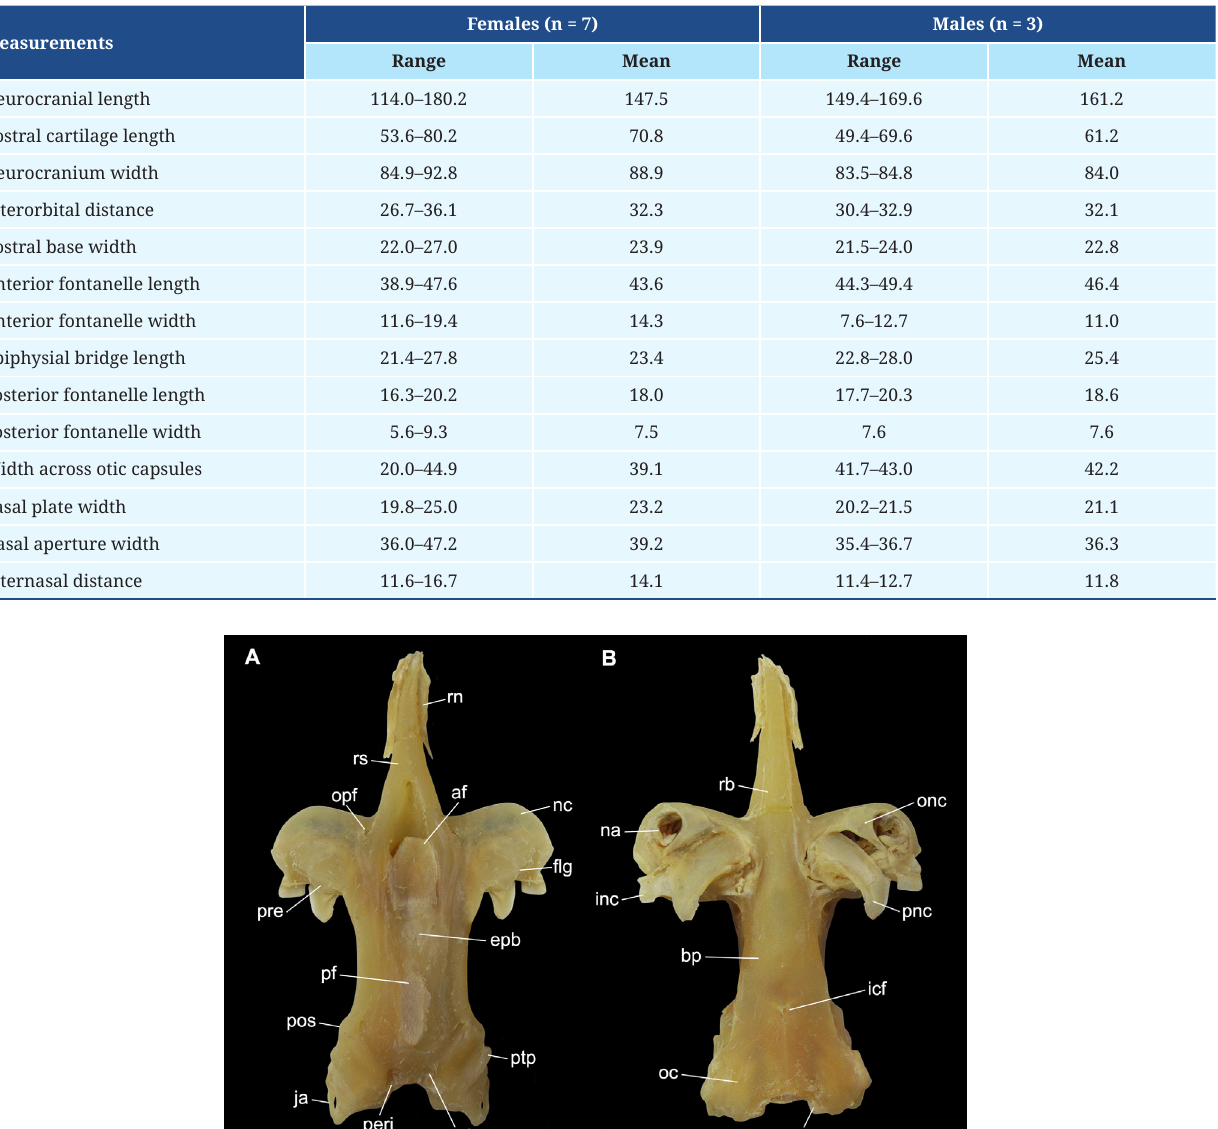
TABLE 7 | Neurocranial measurements in percentages of nasobasal length (% NL) of male and female specimens of Atlantoraja platana .